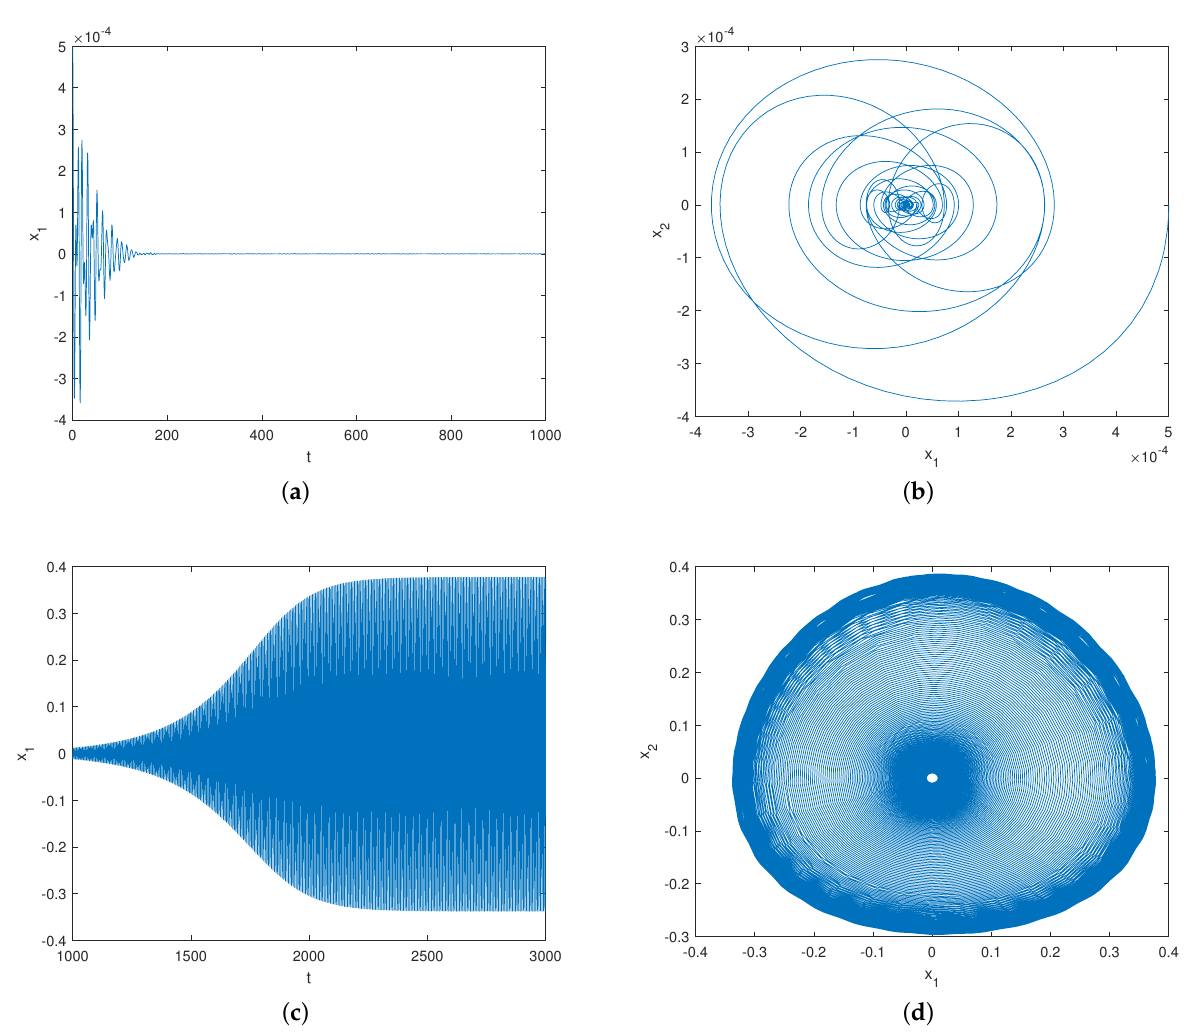
Figure 9. The time history diagram and phase diagram of the system. ( a , b ) Region I in Figure 6, ( c , d ) Region VI in Figure 6.